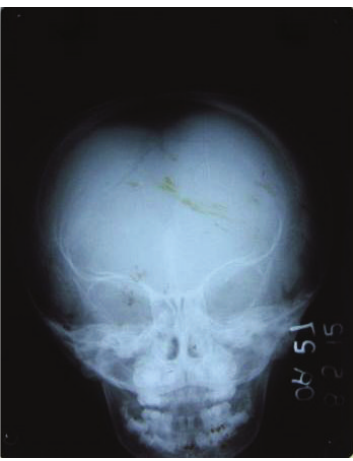
Figure 4: PA view